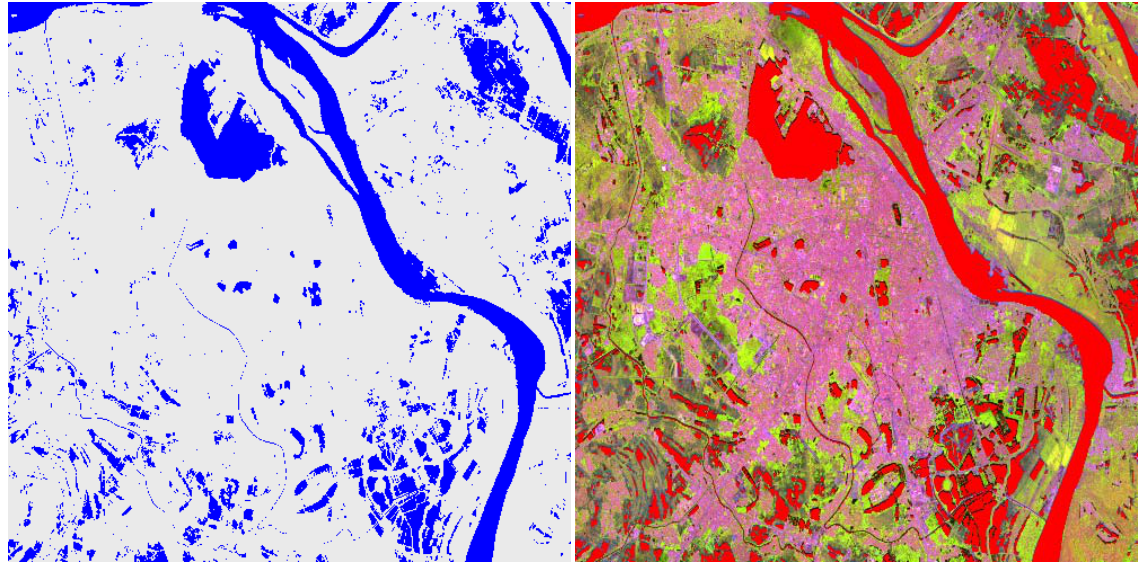
Figure 7. Water extraction by Landsat 5 TM image (left) and overlay on colour composite (right)